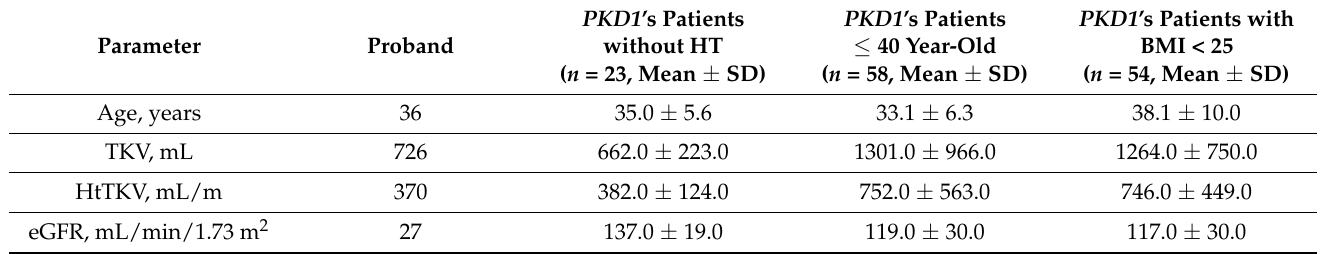
Table 2. Clinical features of the proband when compared with three different PKD1 cohorts in our